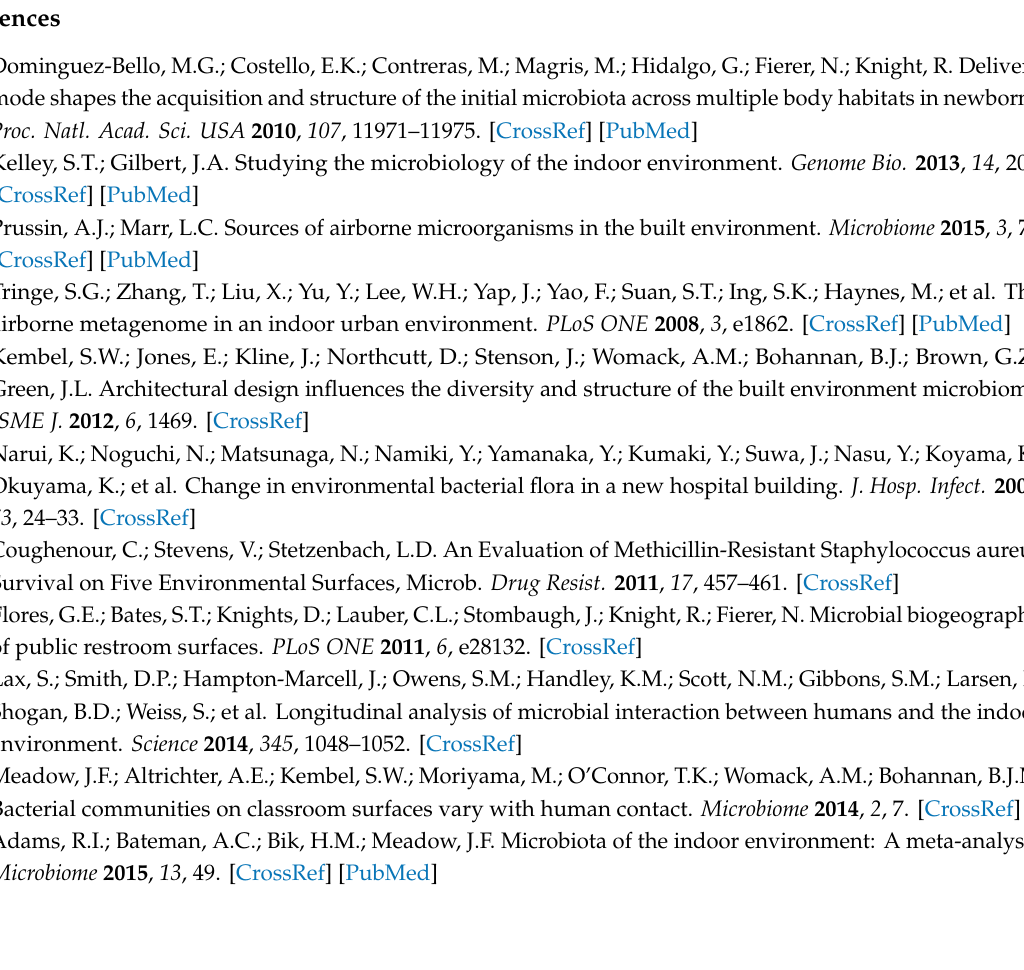
Figure S1: Predictive margins for OTU levels from floor surfaces based on tra ffi c levels, Figure S2: Relative abundance of bacterial community at the class level form di ff erent floor materials, tra ffi c level, and building types, Table S1: Summary of sampling locations (and areas within), floor types and tra ffi c types, Table S2: Bacterial richness indices of the samples presented as mean (standard